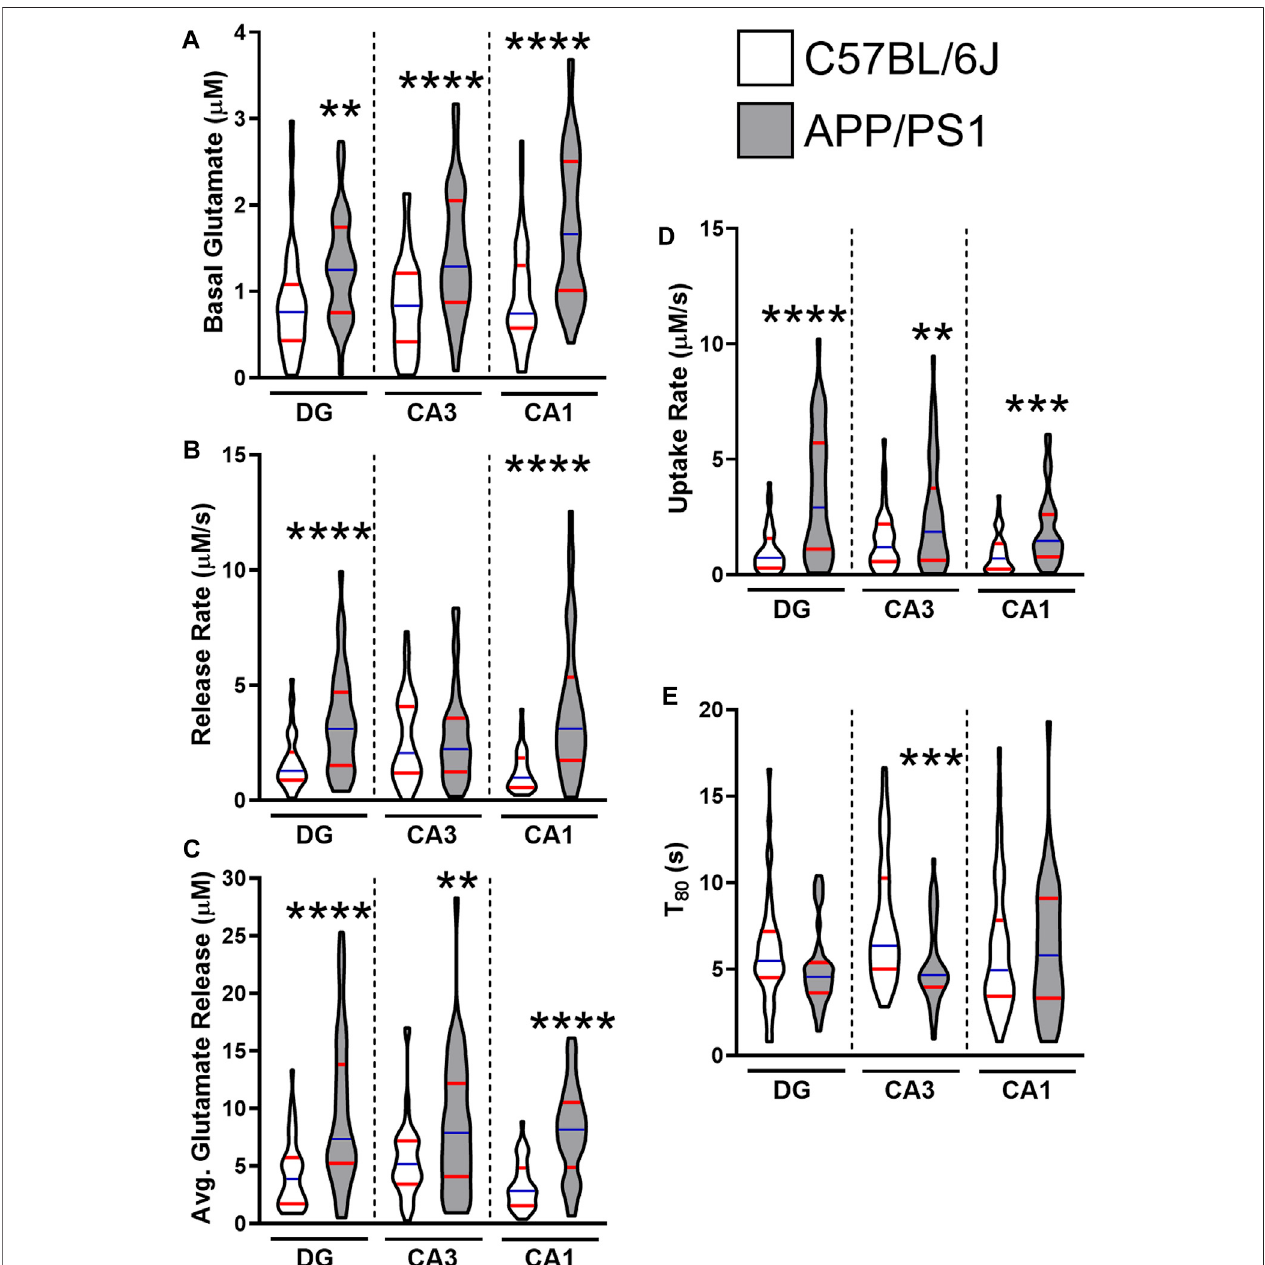
FIGURE1| GlutamatedynamicsinAPP/PS1andC57BL/6Jmiceat12 months.The fi gureswerecreatedusingcontrol12 – 15 monthsmaleC57BL/6J(white)and APP/PS1 (gray) mice across multiple datasets (Hascup E. R. et al., 2019; Hascup K. N. et al., 2019; Hascup et al., 2020a). Graphs depict violin plots with median (blue line) and quartiles (red line). (A) Basal glutamate levels were measured in the CA1, CA3, and the DG of the hippocampus using a microelectrode array (MEA). (B) Glutamate release rate wascalculatedusing the change in amplitude betweenthe maximal responseand baselineover the duration (s)toreach maximal response after stimulation. (C) Average glutamate release was determined using themaximal changeafter stimulation from baseline. (D) Glutamate clearance followed fi rst-order- rate kinetics. A logarithmic slope for glutamate concentration decay (k − 1 ) versus time (s − 1 ) is estimated using regression analysis (R 2 ≥ 0.9) to determine the uptake